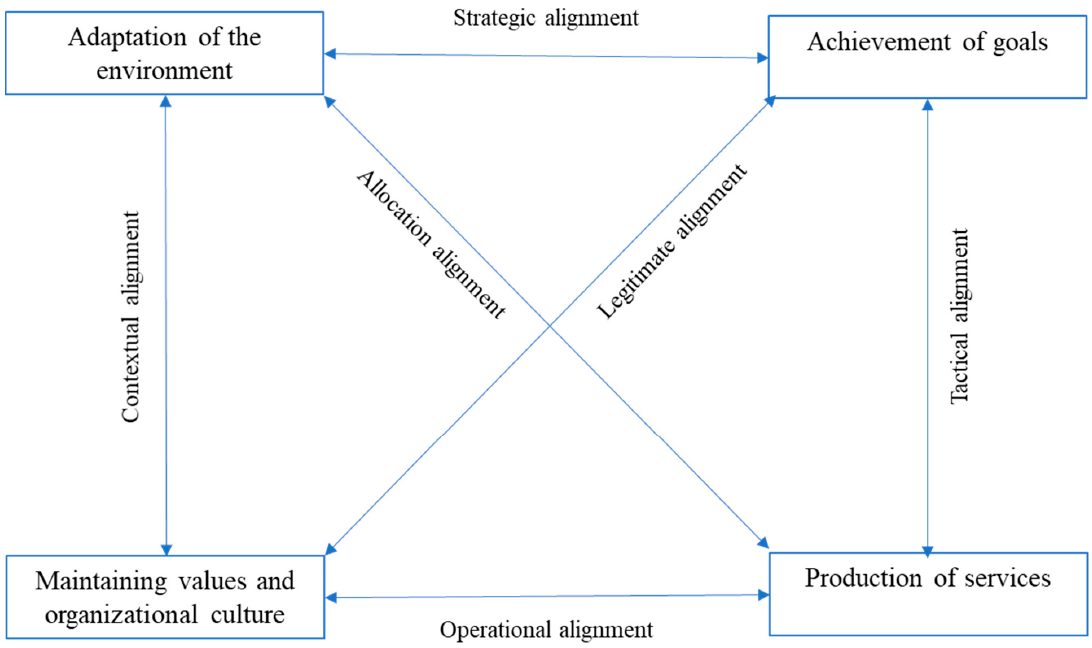
Figure 2. Four functional systems of health care organizations and their six interchange subsystems [11].